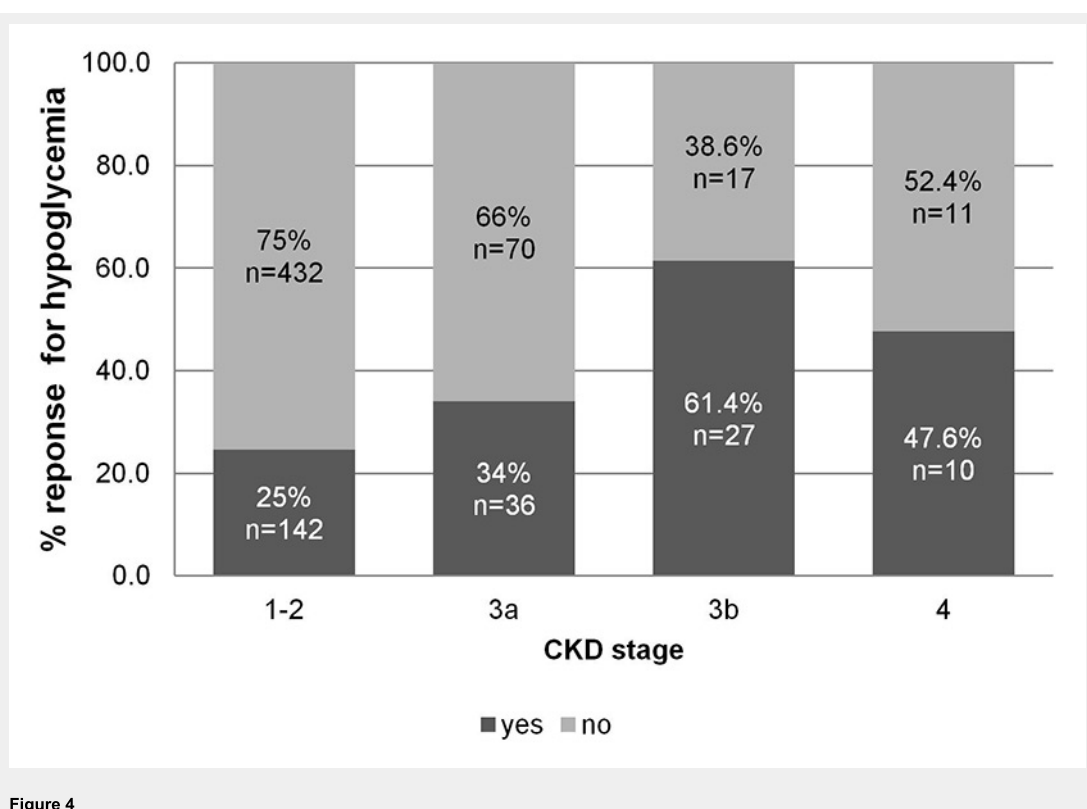
Figure 4 Presence of hypoglycaemia and chronic kidney disease (CKD)